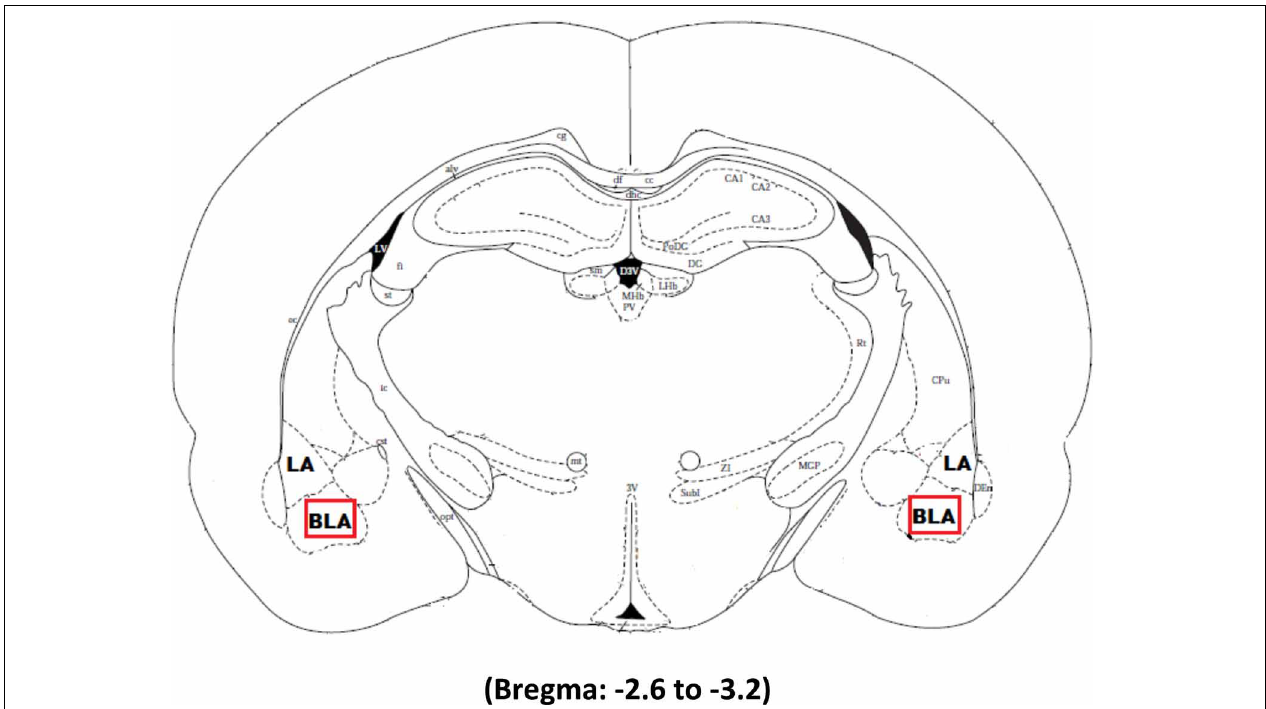
FIGURE 1 | The boxed square represents the area of interest between − 2.6 and − 3.2 from Bregma selected for quantification of Arc signal in the right and left basolateral amygdala after